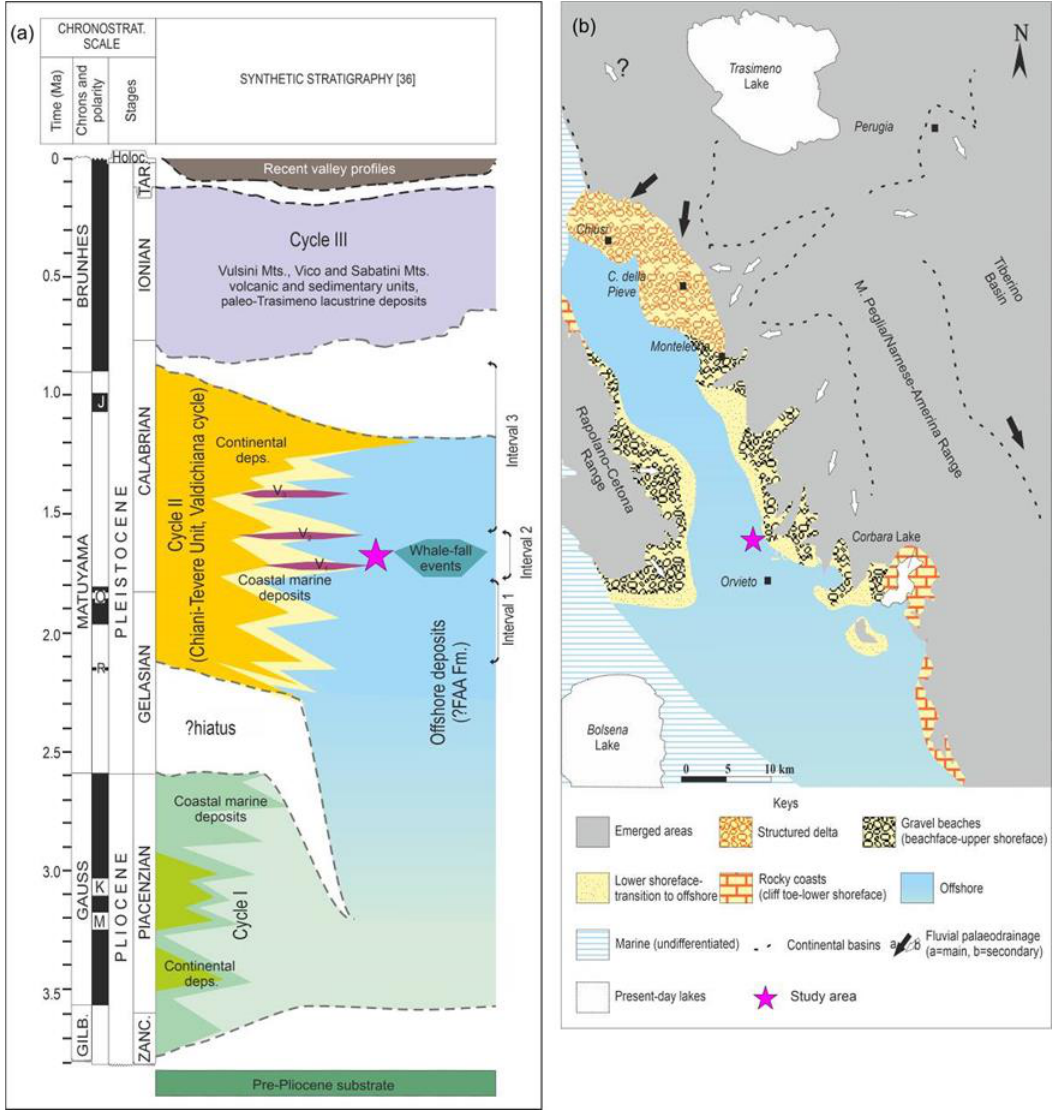
Figure 2. ( a ) Summarised stratigraphic scheme for the study area. ( b ) Early Pleistocene paleogeo- graphic restoration. Modified after [28].